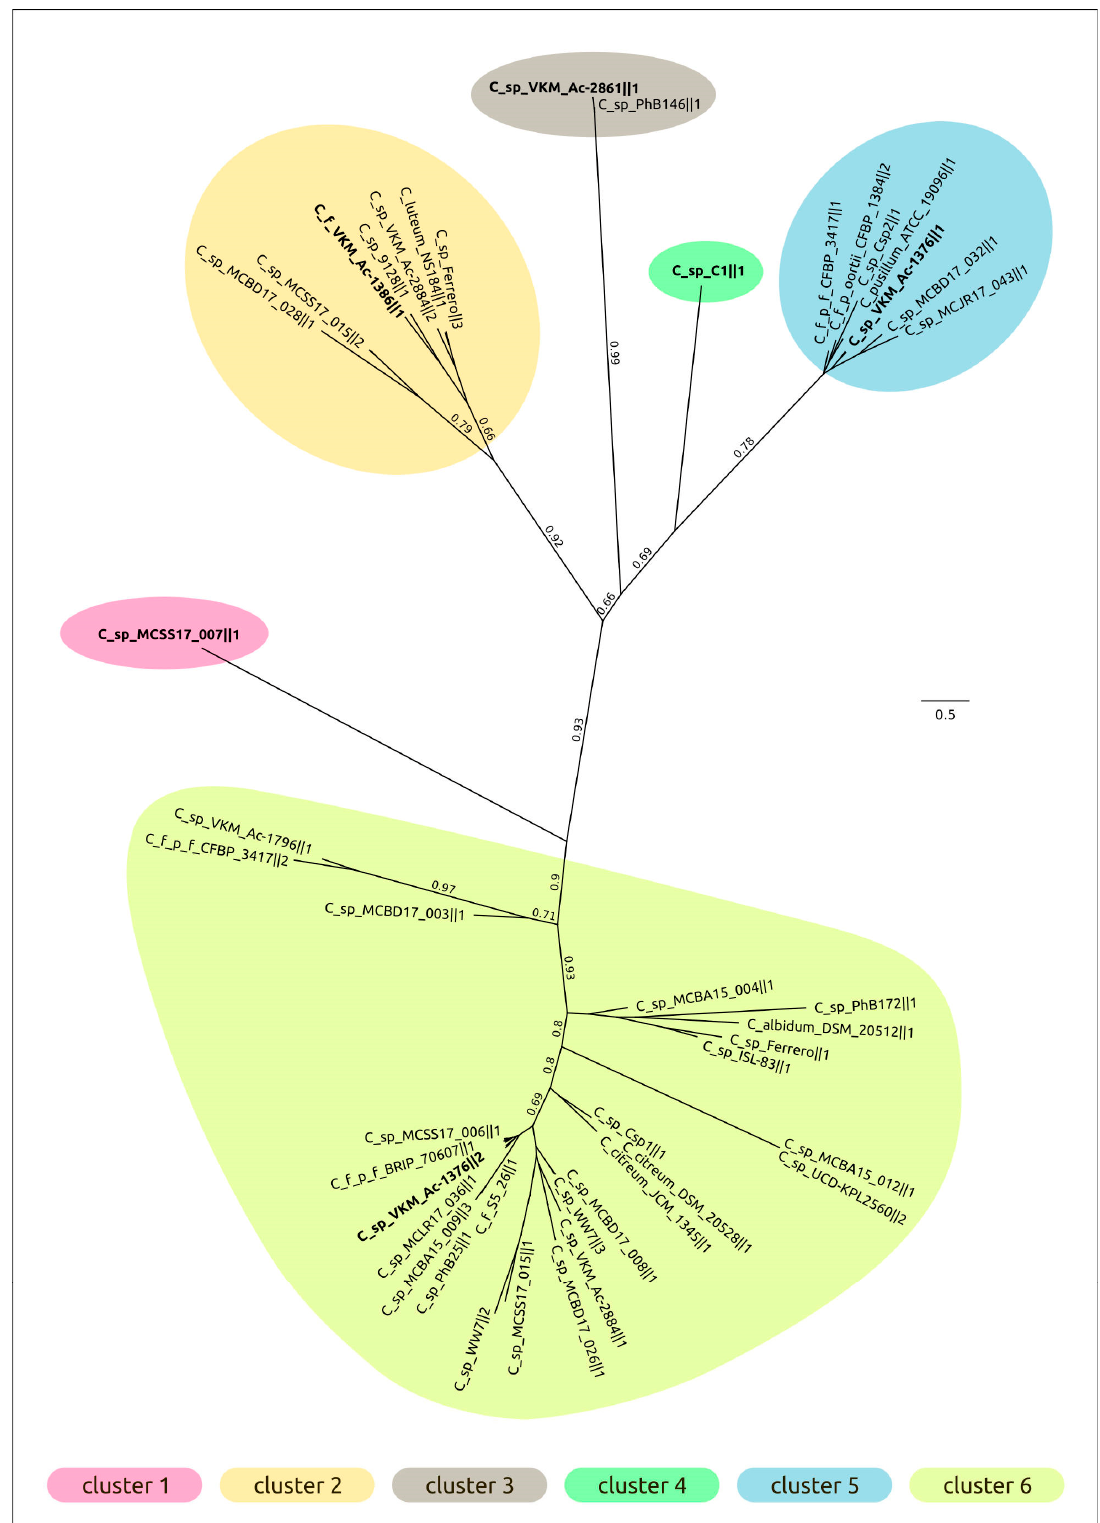
Figure 7. Best-scoring ML phylogenetic tree constructed with 58 amino acid sequences of endolysins. The numbers near the tree branches indicate the TBE values. The total number of bootstrap trees was 1000. The scale bar shows 0.5 estimated substitutions per site and the tree was unrooted. Background colours indicate the clustering proposed for the analysis.